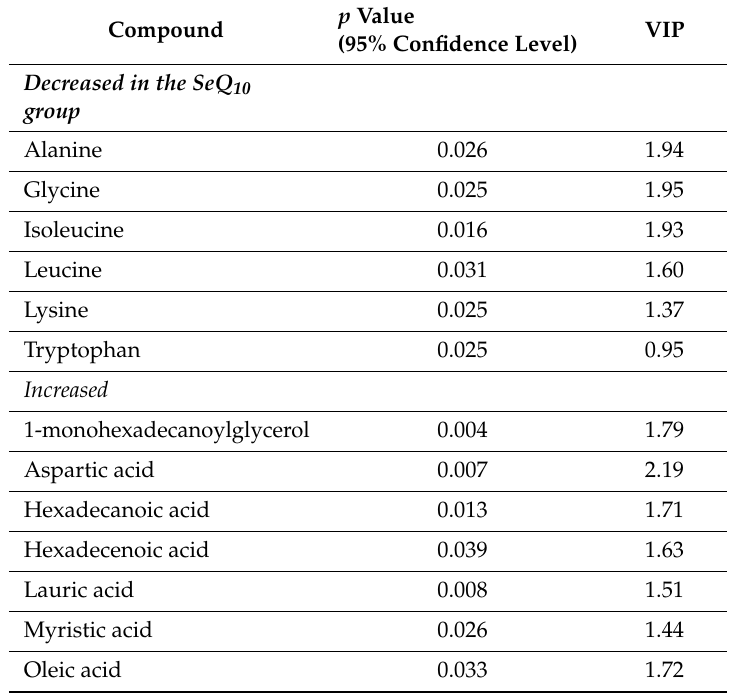
Table 3. Compounds that were found significant according to T-test in at least one batch when SeQ 10 and controls at 18 months were compared, with the corresponding p -value and VIP value from this batch.